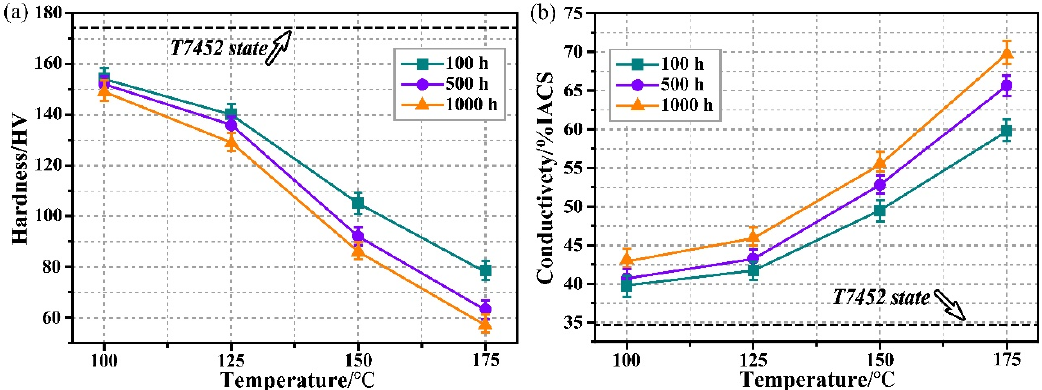
Figure 1. Effects of thermal exposure and tensile test temperature on hardness ( a ) and electrical conductivity ( b ) of 7085-T74 Al alloy.